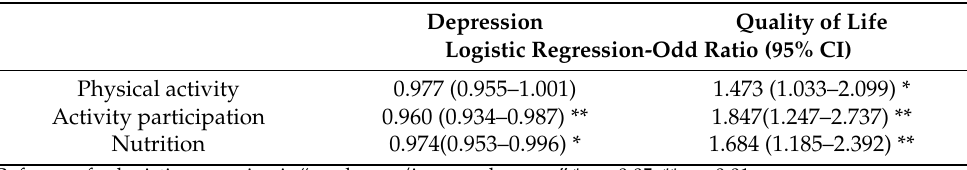
Table 5. Associations between variation in lifestyle and psychological